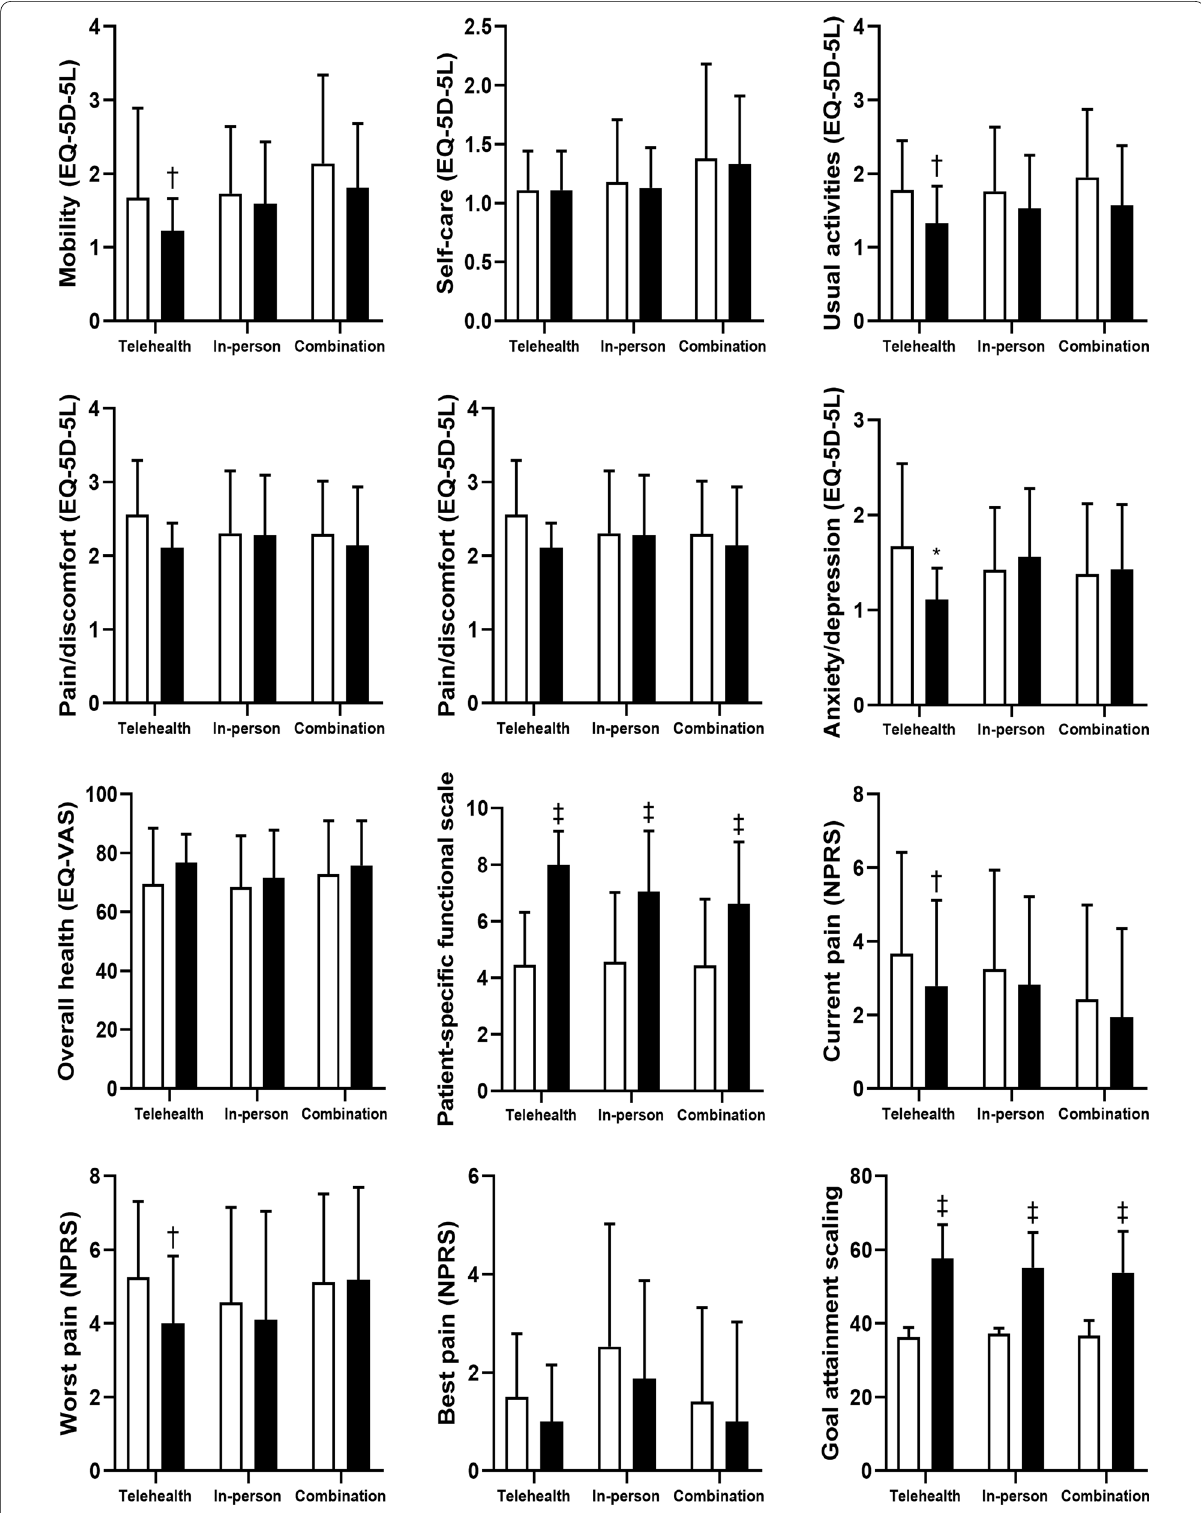
Fig. 1 Effects of an exercise physiology treatment phase on patient outcomes by delivery mode. Telehealth: telehealth delivery only ( n In-person: in-person delivery only ( n 82), Combination: combination of telehealth and in-person delivery ( n = compared to baseline. White bar: Baseline, Black bar: